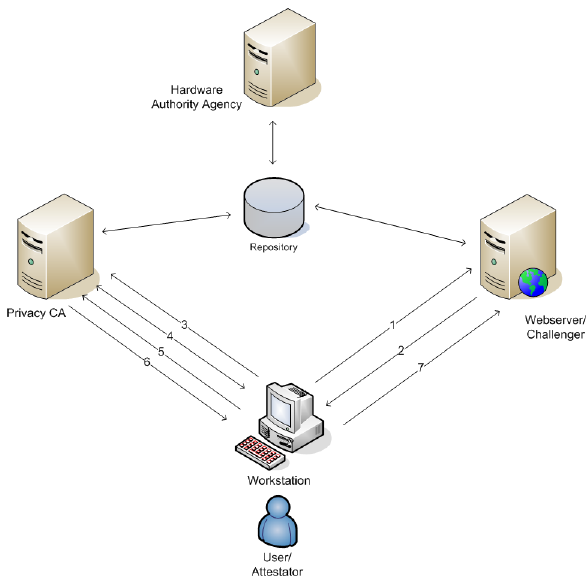
Figure 2. Attestation Using Privacy Certification Authority